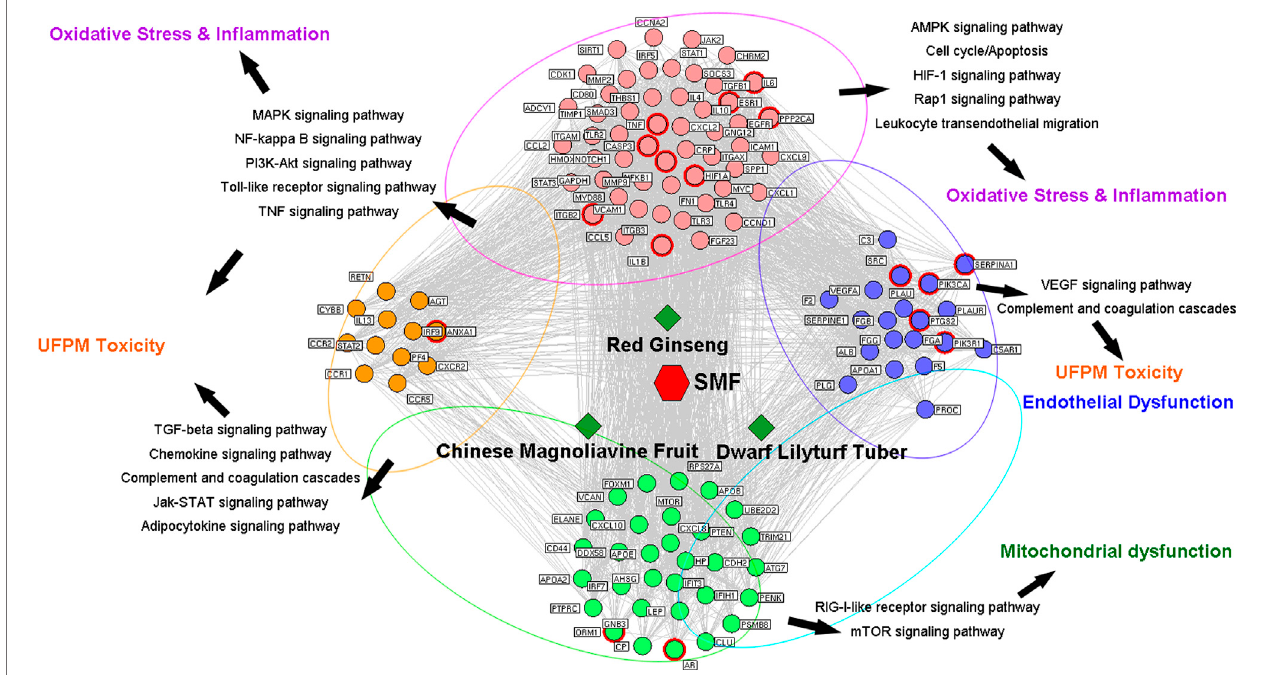
FIGURE 4 | UFPM, Cardiovascular disease-drug target-pathway network. The red node at the center of the fi gure corresponds to the Shengmai formula and the surrounding green diamond-shaped nodes are the three Chinese herbal medicines (Ginseng radix et Rhizoma Rubra, Ophiopogonis Radix, and Schisandrae Chinensis Fructus). The round nodes represent the key network targets in the “ disease gene-drug target interaction network, ” where the red circles (the marked target genes) are candidatesfortheShengmaiformula,andtheothersaredisease-relatedgenes.Theedgesrepresentinteractionsamongcardiovasculardiseasegenes,herbs,and putative targets for the treatment of cardiovascular disease. The different color ovals represent the main pathways from the enrichment analysis of major targets in the “ disease gene-drug target interaction network ” and the previously described toxicity pathways of UFPM.